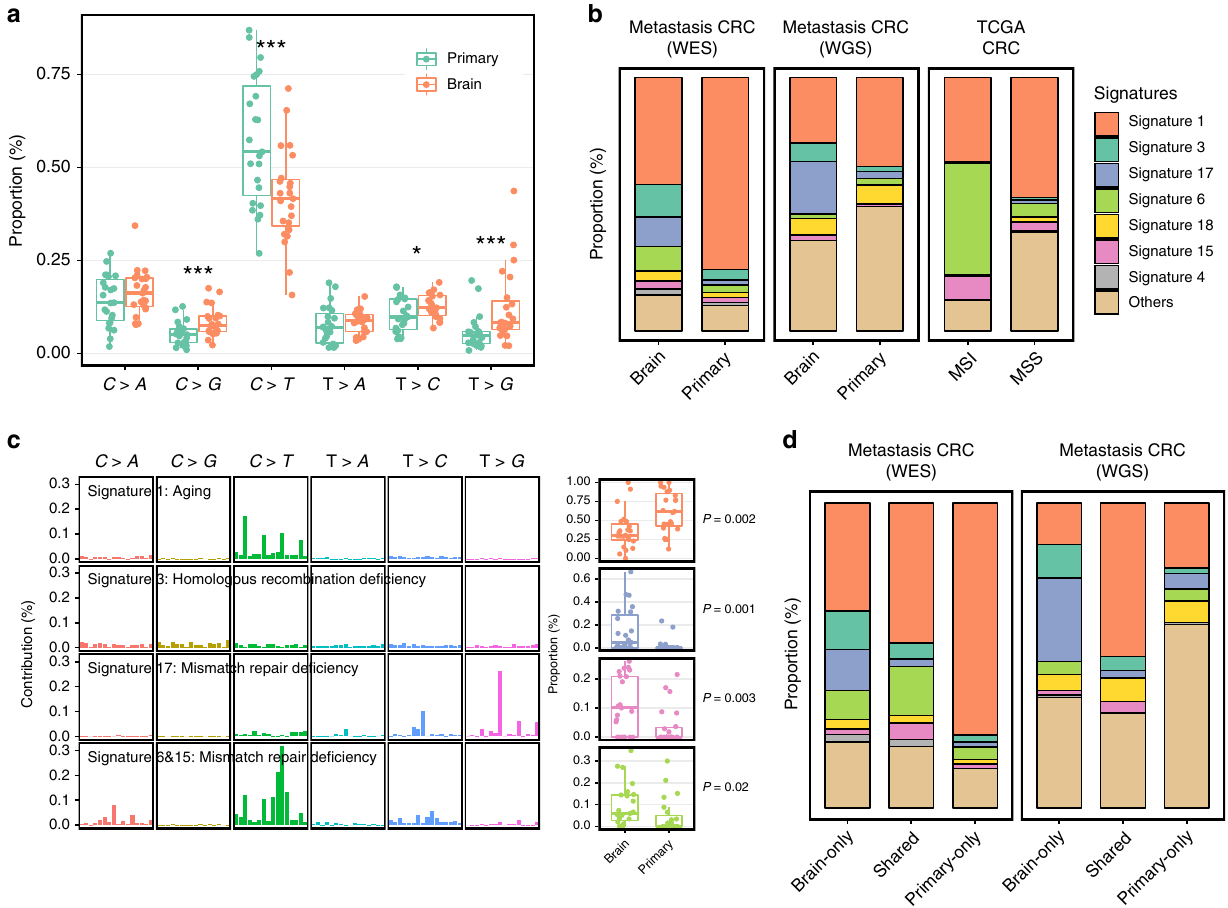
Fig. 1 Divergent mutational features in brain metastases and matched primary tumors of CRC patients. a Six mutational subtypes in BM and primary tissues. The BM tissues are presented in orange, and the primary tissues are presented in cyan. b Major mutational signatures in our patients and TCGA CRC patients. We reconstructed the proportion of mutational signatures of each sample based on a prede fi ned mutational spectrum of 30 COSMIC signatures. The proportion of the top seven signatures in BM is presented. c HRD and MMRD signatures were signi fi cantly elevated in BM tissues compared with those in primary tissues. Four mutational signatures with a signi fi cant difference between BM and primary tissues are shown in the fi gure. The mutation characteristics are presented at the left side and the box plot of the proportion of each signature is presented at the right side. The box plot displays the fi rst and third quartiles (top and bottom of the boxes), median (band inside the boxes), and lowest and highest point within 1.5 times the interquartile range of the lower and higher quartile (whiskers). d All mutations were classi fi ed into three groups — brain only, shared and primary only — and mutational signatures were extracted in each